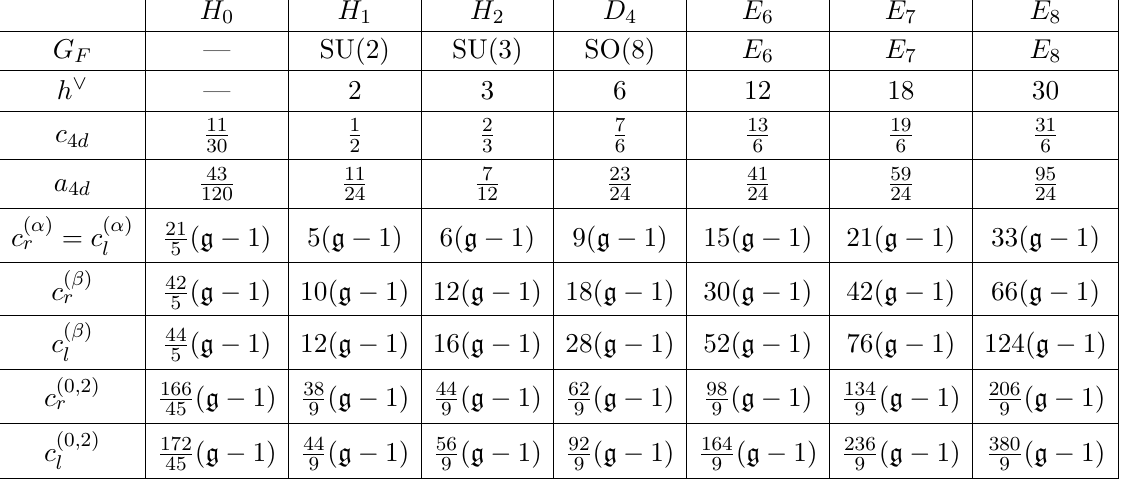
Table 1 . Flavor symmetries, dual Coxeter numbers, and 4d and 2d conformal anomalies for “rank 1”